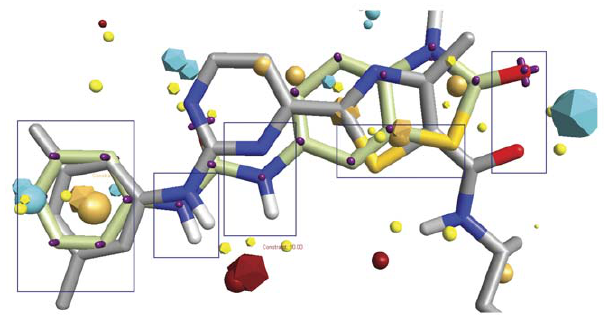
Figure 17. Similarity of urea-based derivative 12a with a Syk kinase inhibitor using field alignment method. The boxes highlight regions of high field similarity. Both of the inhibitors are having thiazole moiety if we considered structural similarity.